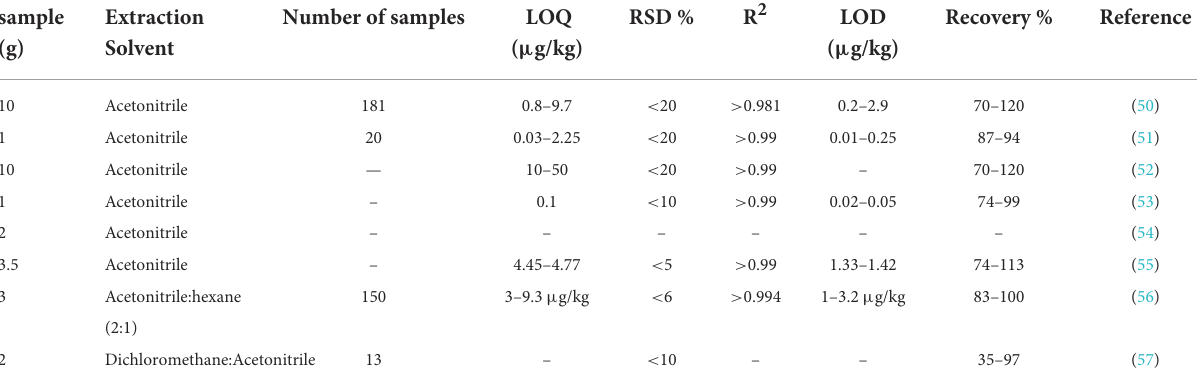
TABLE 2 Experimental conditions for extracting coffee samples and the analytical parameters of the method.